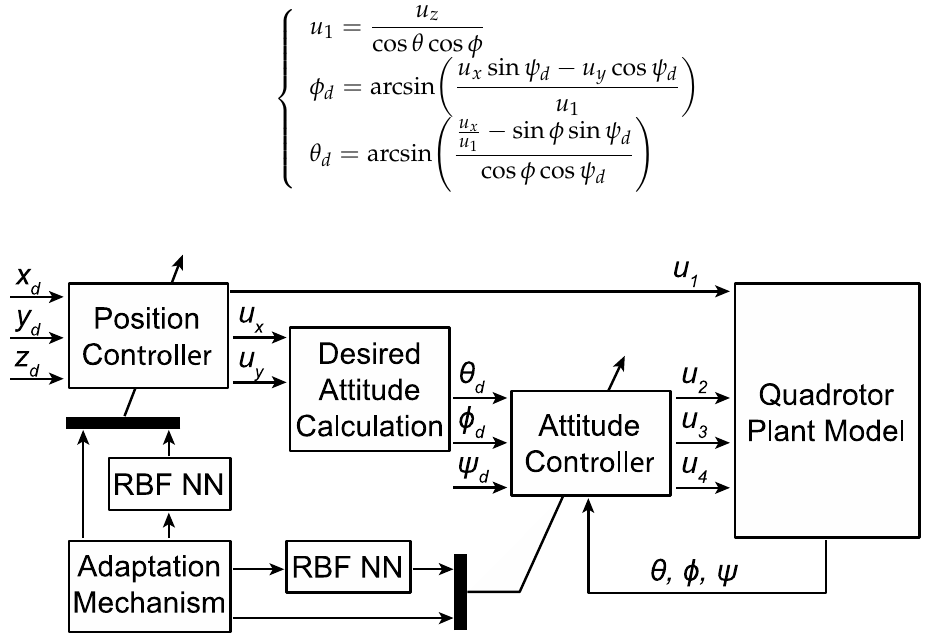
Figure 2. Schematic diagram of the closed-loop neural network-based adaptive quadrotor control system.